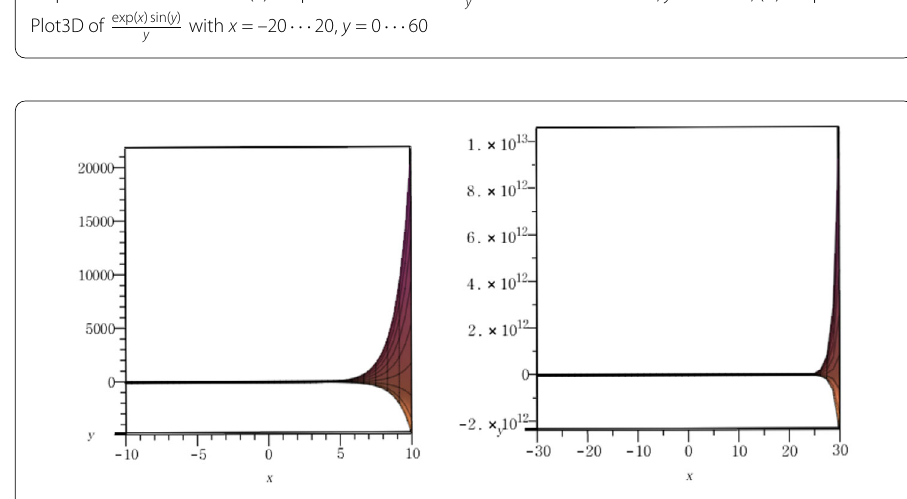
with x = –10 ··· 10, y = 0 ··· 10; ( b ) output of y